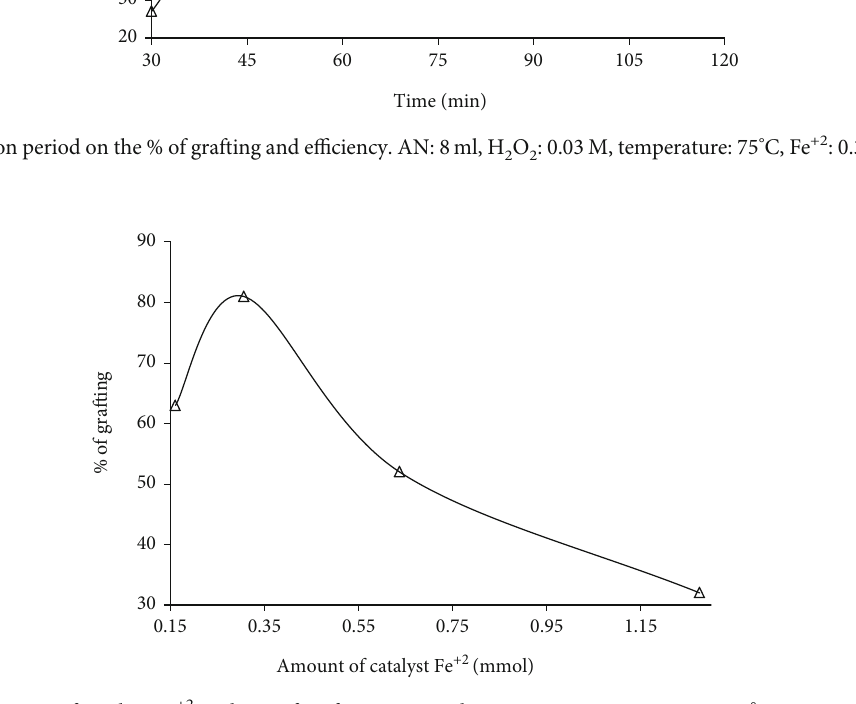
: 0.03M, temperature: 75 ° C, time: 60 min, and ( Δ ): % of 2